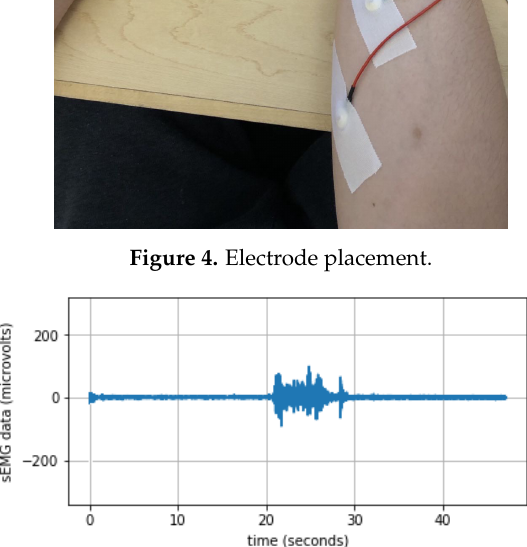
Figure 5. An example of recorded sEMG signal after